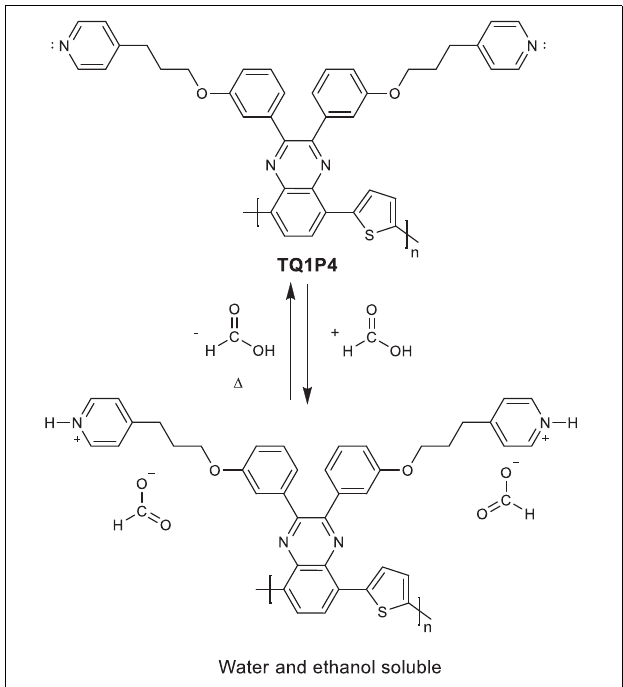
FIGURE 3 | Cyclic voltammetry (CV) oxidation curves of (A) TQ1A in the solid state and triethylamine in solution, (B) TQ1P4 in the solid state and pyridine in solution.